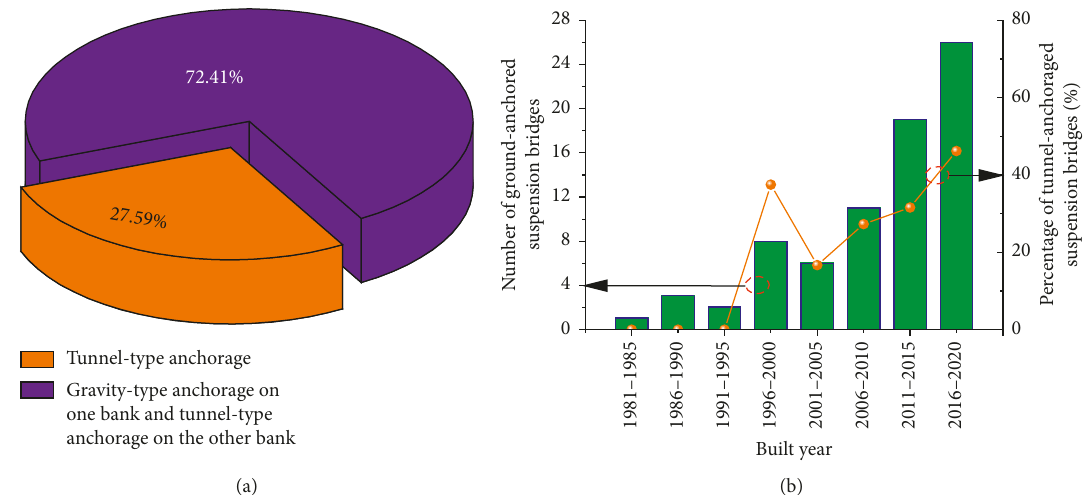
Figure 4: (a) The proportion of suspension bridge with TTA on both banks and only one bank. (b) Development trend of